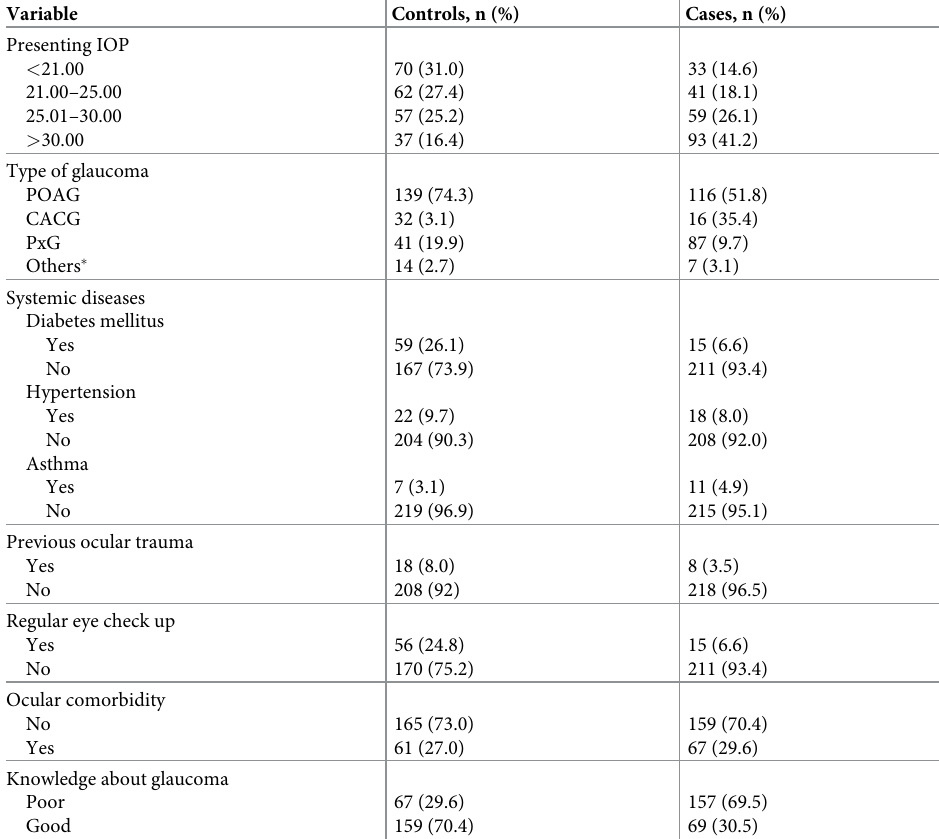
Table 2. Ocular related factors among adult glaucomatous patients in University of Gondar Comprehensive Spe- cialized Hospital, Northwest Ethiopia, 2020. Variable Controls, n (%) Cases, n (%) Presenting IOP <